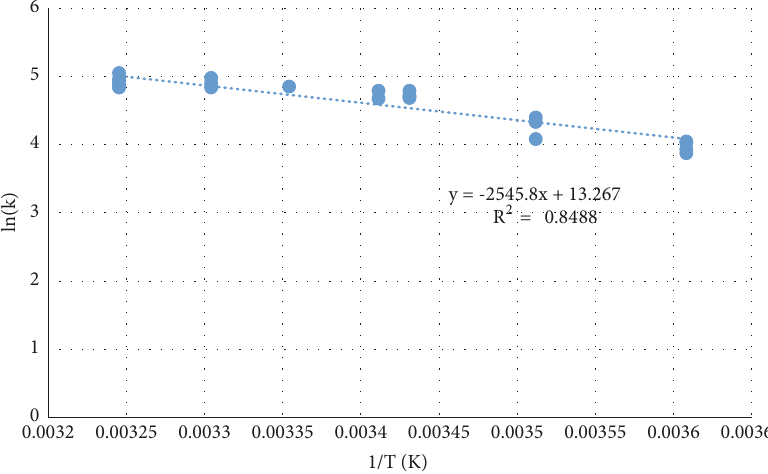
Figure 3: Arrhenius plot for MC-LA over the temperature range 4 ∘ C to 35 ∘ C.